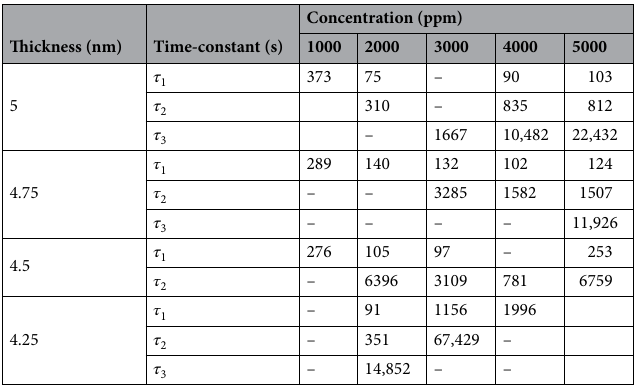
Table 1. Fitted values of time constants 𝜏 1 , 𝜏 2 and 𝜏 3 obtained at different concentrations of H 2 gas for ultra- thin Pd films of varying